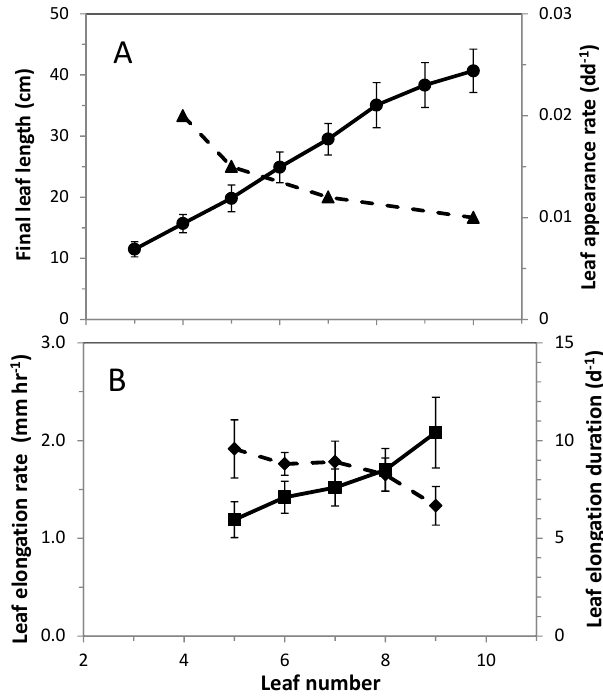
Figure 2. Leaf growth components (appearance and elongation rates, elongation duration, final length) of successive leaves on the ryegrass ( Lolium perenne ) main tiller of undefoliated plants. ( A ) ● : final leaf length; ▲ : leaf appearance rate; ( B ) ♦ : leaf elongation rate; ■ : leaf elongation duration. Plants were grown under constant controlled conditions. Redrawn and completed from